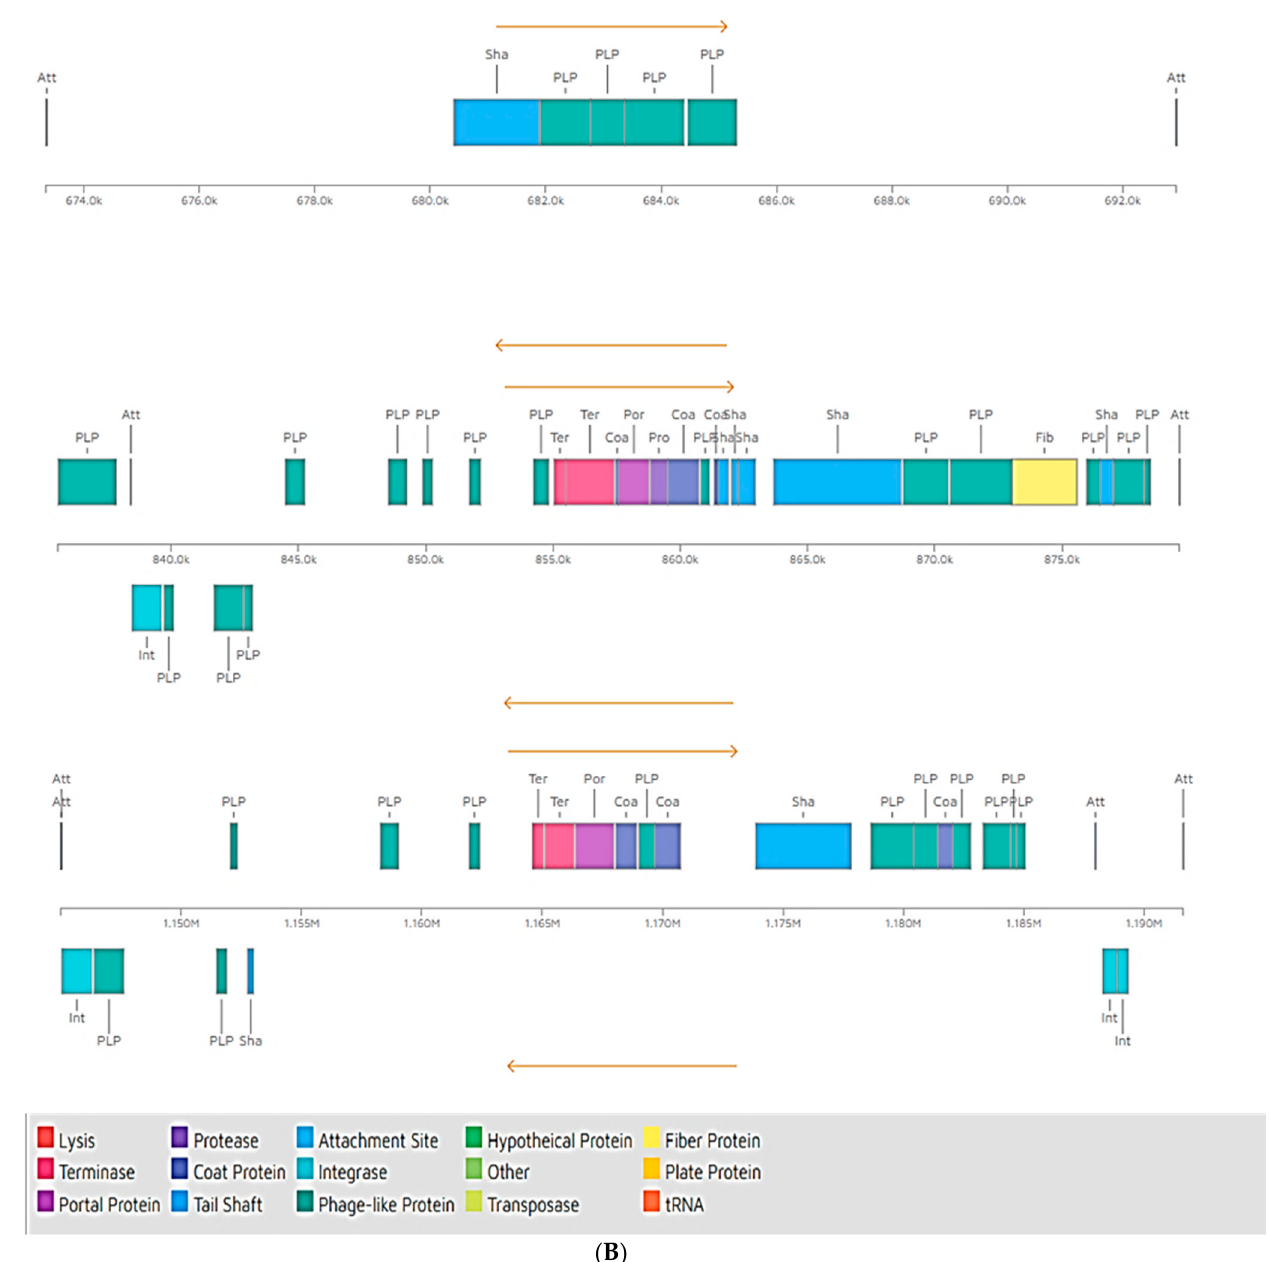
Figure 4. Phage site prediction by PHASTER. ( A ) Complete genome prediction of L. plantarum 13-3 showing the phage regions in the lactobacillus plantarum genome. ( B ) Expanded view of genome showing phage sites.